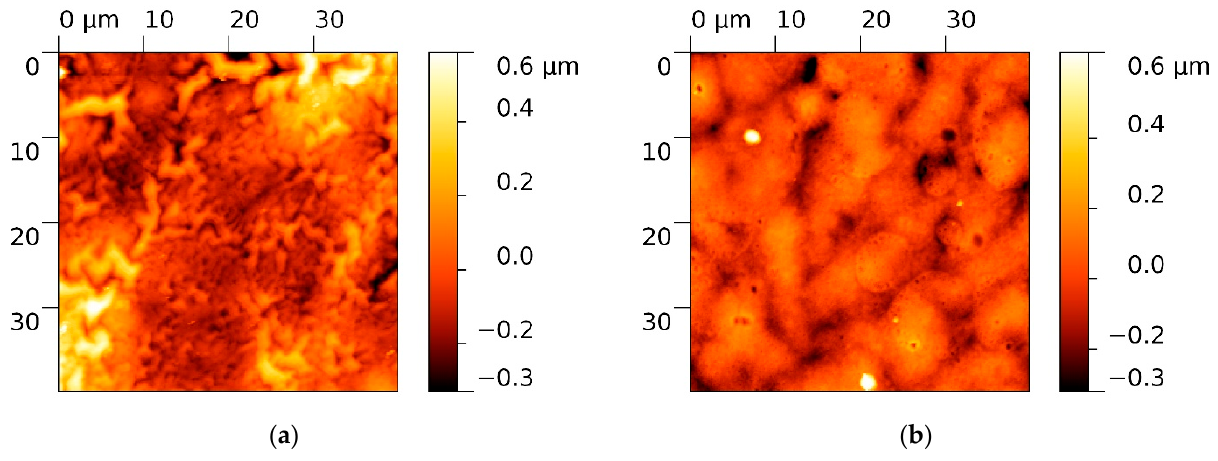
Figure 2. AFM images of the ( a ) SnCl 2 (acac) 2 donor surface, ( b ) Pd-SnCl 2 (acac) 2 donor surface. The parameters describing the surface morphology (Rq, Min, Max, Rsk), as extracted from AFM scans, are collected in Table 1. The average squared roughness value (Rq)